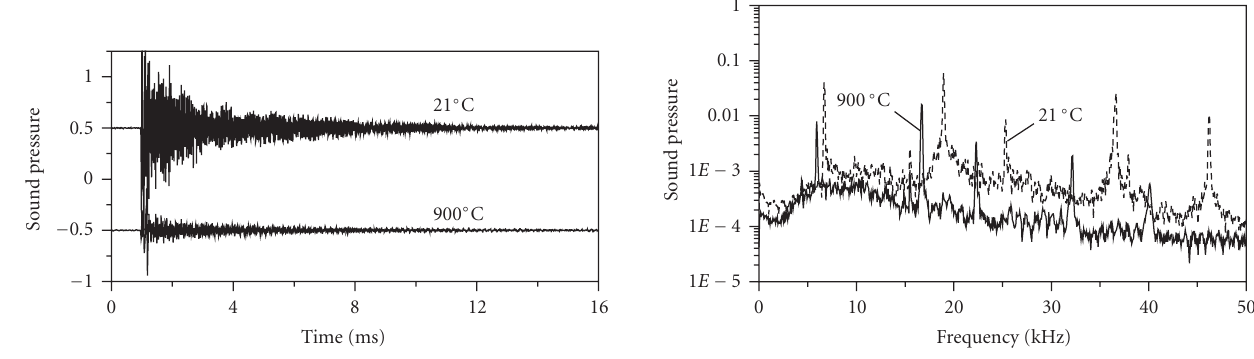
Figure 3: Time history and frequency spectra of the impact responses of specimen B1 at room temperature (21 ◦ C) and high temperature (900 ◦ C).